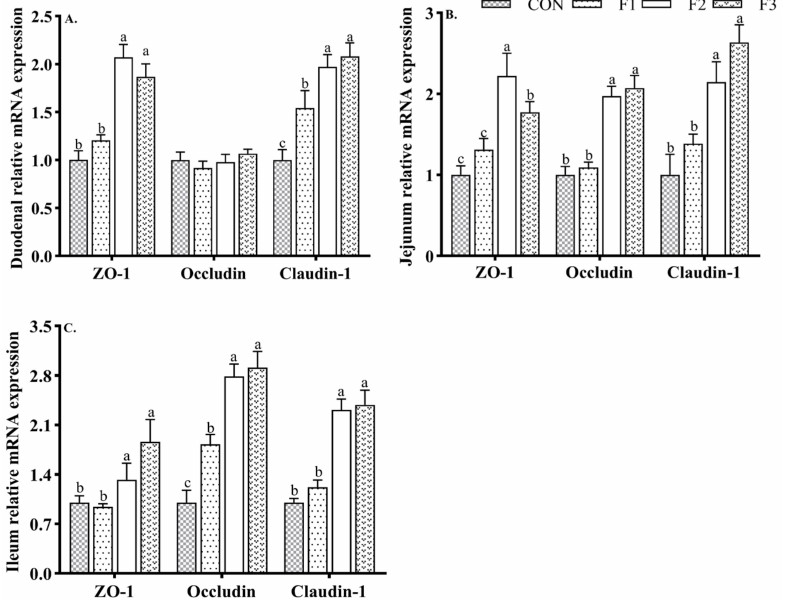
Figure 4. Effects of dietary fucoidan supplementation on intestinal tight junction protein mRNA expression level in weaned goat kids. ( A ) Duodenal tight junction protein mRNA expression level; ( B ) jejunum tight junction protein mRNA expression level; ( C ) ileum tight junction protein mRNA expression level. Results are presented as mean ± SEM. a–c means significantly different ( p < 0.05). CON, basal diet; F1, basal diet + 0.1% fucoidan; F2, basal diet + 0.3% fucoidan; F3, basal diet + 0.5% fucoidan. ZO-1, zonula